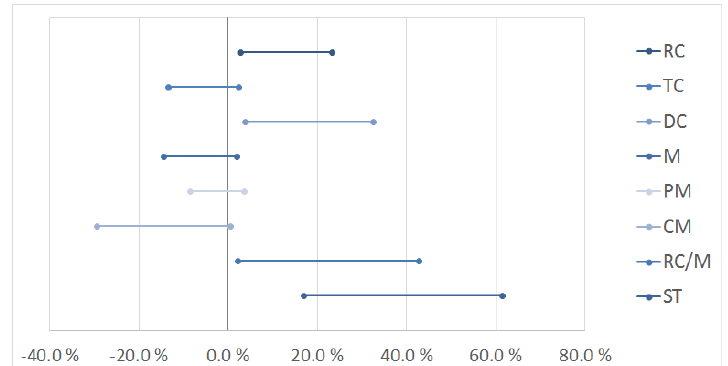
Figure 3. Ninety-five percent confidence interval for the difference in solution time and solution quality for RHH-2 with a planning period of two and three shifts. Positive differences mean that the values of a planning period of three shifts are greater than for a planning period of two shifts.